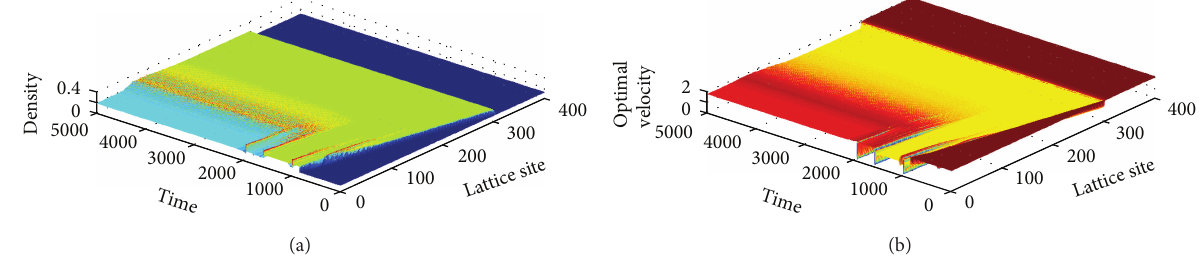
Figure 12: The spatiotemporal evolutions for 𝜌 ℎ = 0.12 , 𝑄 on = 0.14 .